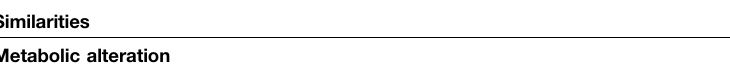
TABLE 3 | A comparison of the fi ndings of HIV infection and TB plasma metabolomics